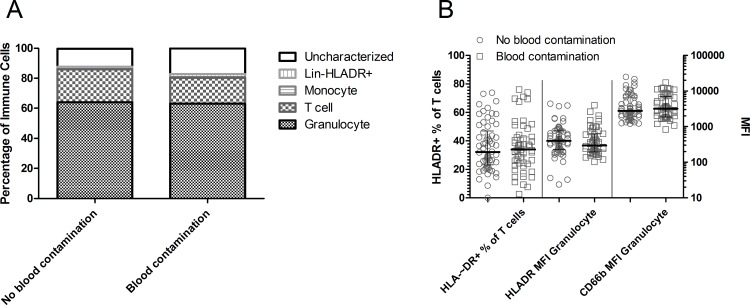
Comparison of nasal curettes with visible red blood cell contamination (n = 55) or not (n = 62).(A) Median proportions of granulocytes, T cells, monocytes, lineage- HLA-DR+ and uncharacterized cells among immune cells. (B) The percentage of HLA-DR+ T cells (left axis) and mean fluorescent intensity (MFI) of HLA-DR and CD66b on granulocytes (right axis) of nasal curette samples visibly contaminated with erythrocytes (open squares) or not (open circles). Individuals samples and median and interquartile range are shown.